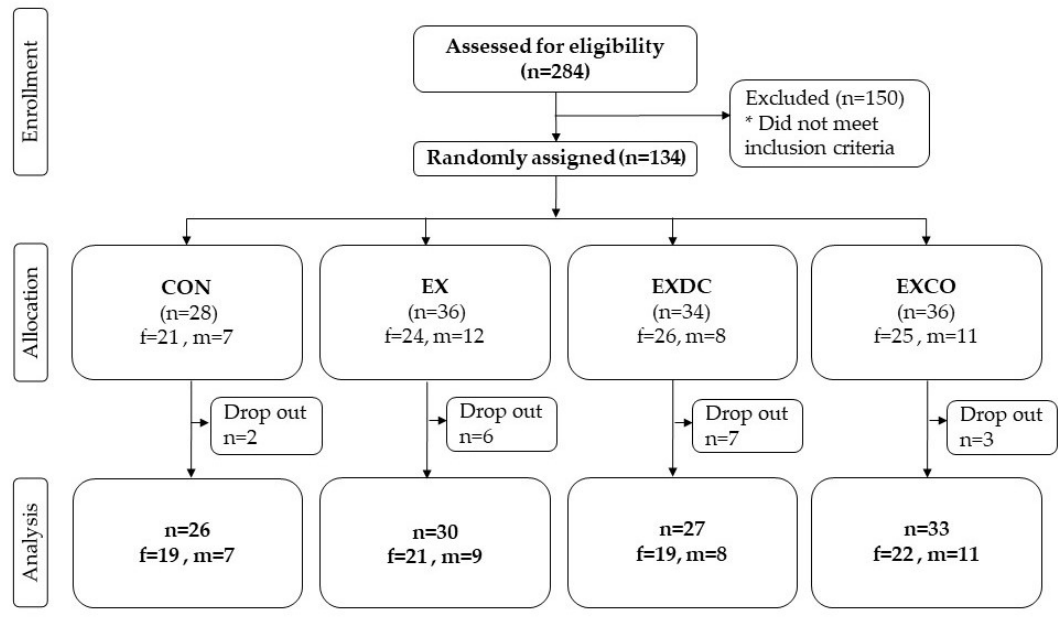
Figure 1. Flow chart of all participants screened, randomized, allocated and analyzed.